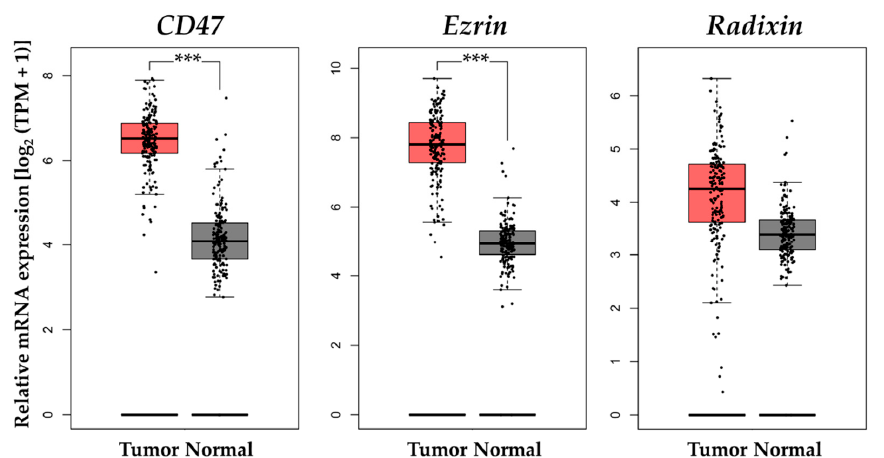
Figure 6. Gene expression analysis of CD47 and ezrin / radixin in the clinical PDAC and normal tissues. Relative mRNA expression values of CD47 , ezrin , and radixin in the tissues of patients with PDAC ( n = 179) and normal ( n = 177) tissues as assessed by the Gene Expression Profiling Interactive Analysis (GEPIA) database. The estimated gene expression values based on RNA-sequencing (seq) data are represented as log 2 (TPM + 1). *** p < 0.001 vs. Normal.